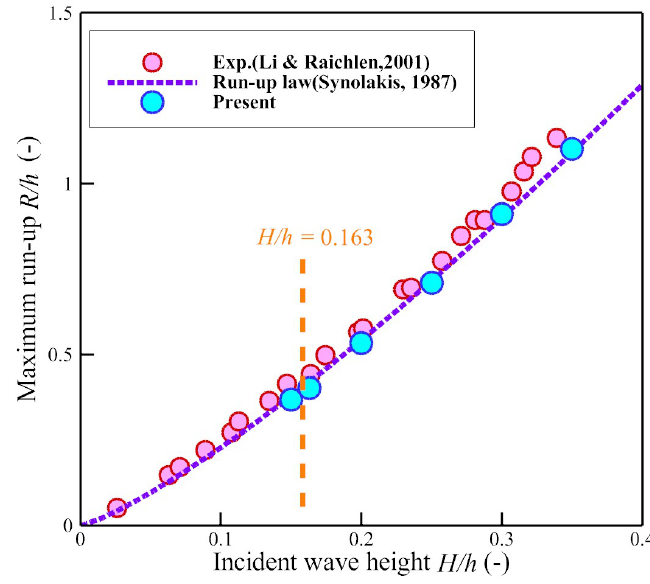
Figure 11. Comparison of the maximum run-up (constant slope angle = 26 ◦ ).